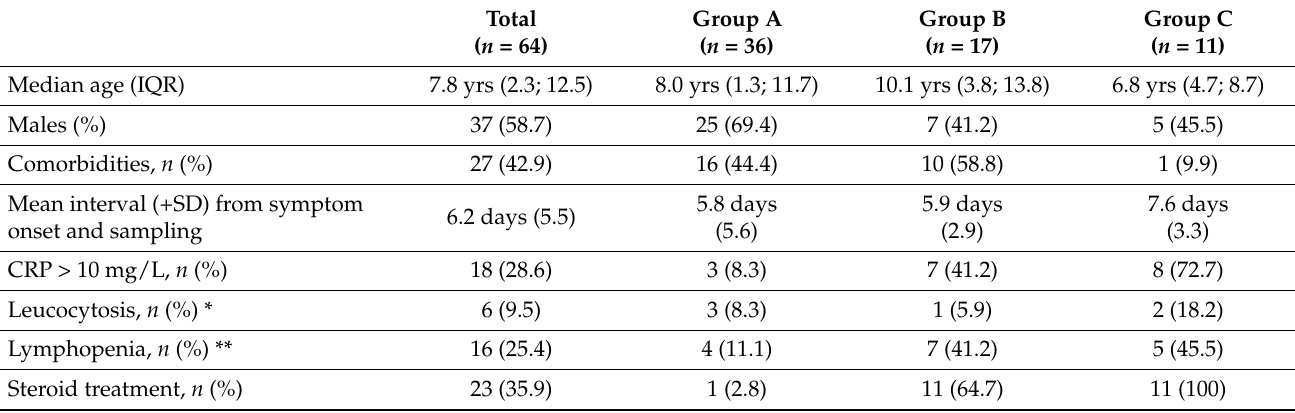
Table 1. Demographics and clinical characteristics of SARS-CoV-2-infected children at the time of sampling. Group A: children with mild symptoms. Group B: children with severe symptoms. Group C: children with MIS-C. n : number; IQR: interquartile range, expressed as 25 ◦ and 75 ◦ quartile values; yrs: years; SD: standard deviation. CRP: C-reactive protein. Values upper * or below ** normal limit according to age-related